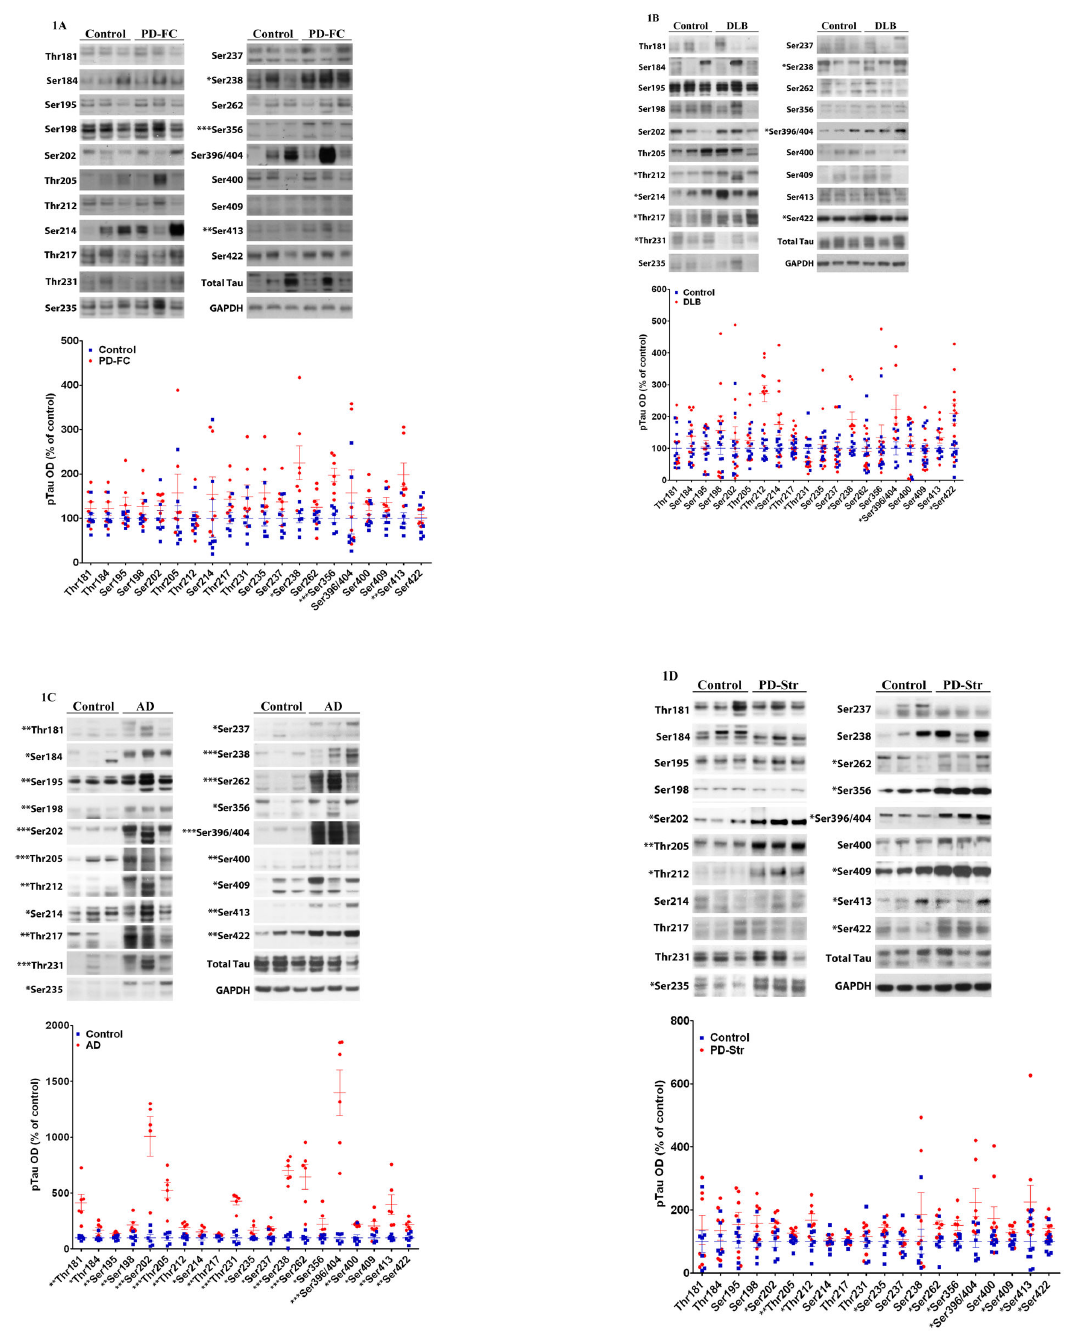
Figure 1. Identification of Tau phosphorylation sites in postmortem human FC from PD, DLB AD and PD striata. Western blot analyses of p-Tau levels were conducted using specific p-Tau antibodies as described in Materials [see Table S1 in File S1]. [A] postmortem FC of human PD cases [N = 7-9] and non-diseased controls [N = 7]; [B] FC from human DLB cases [N = 7-10] and non- diseased controls [N = 7-10]; [C] postmortem FC from human AD cases [N = 5-6] and non-diseased controls [N = 4-6], [D] postmortem striata from human PD cases [N = 7-9] and non-diseased controls [N = 7-10]; Summary of quantitation for opticzal density [OD] of each p-Tau site relative to total Tau is presented as percent of age-matched control. Due to large variation in human tissues, scatter plots were drawn to show variations within each individual control sample [blue squares] or diseased sample [red circles]. Bars show group means ± SEM. Data for each p-Tau site were analyzed by t-test for difference from the control group [*p<0.05]. doi: 10.1371/journal.pone.0075025.g001 PLOS ONE |